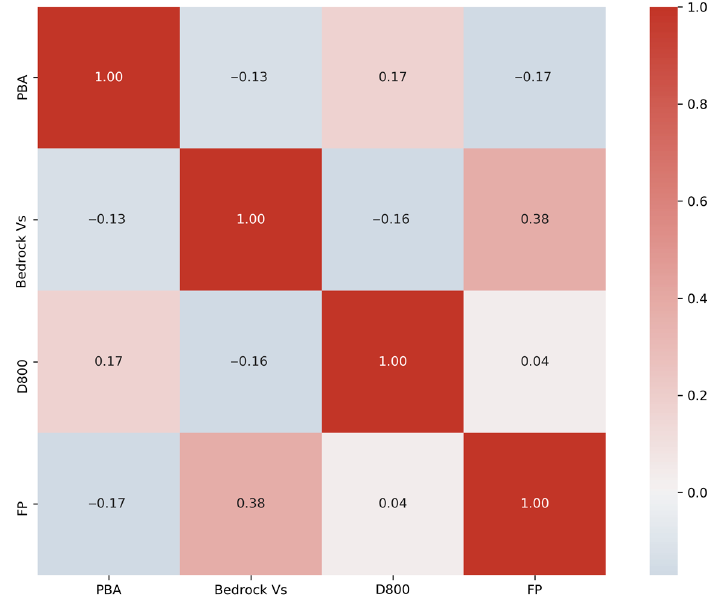
Figure 5. Correlation matrix for input four features.